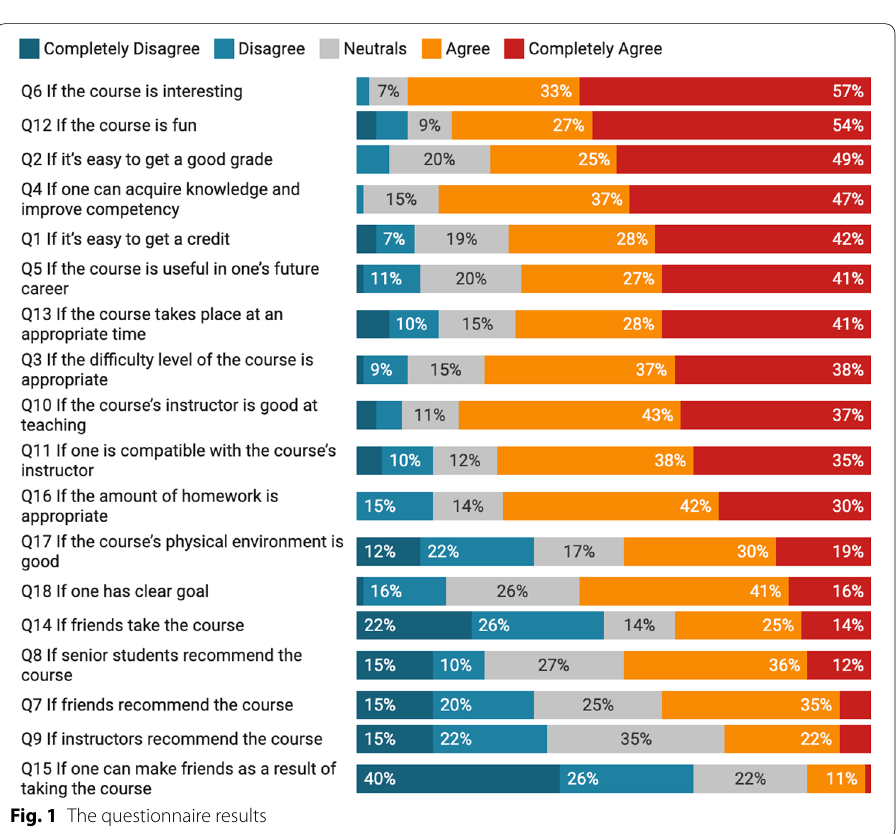
a These are the English translation, which is originally in Japanese b Such as temperature, humidity, WiFi connectivity